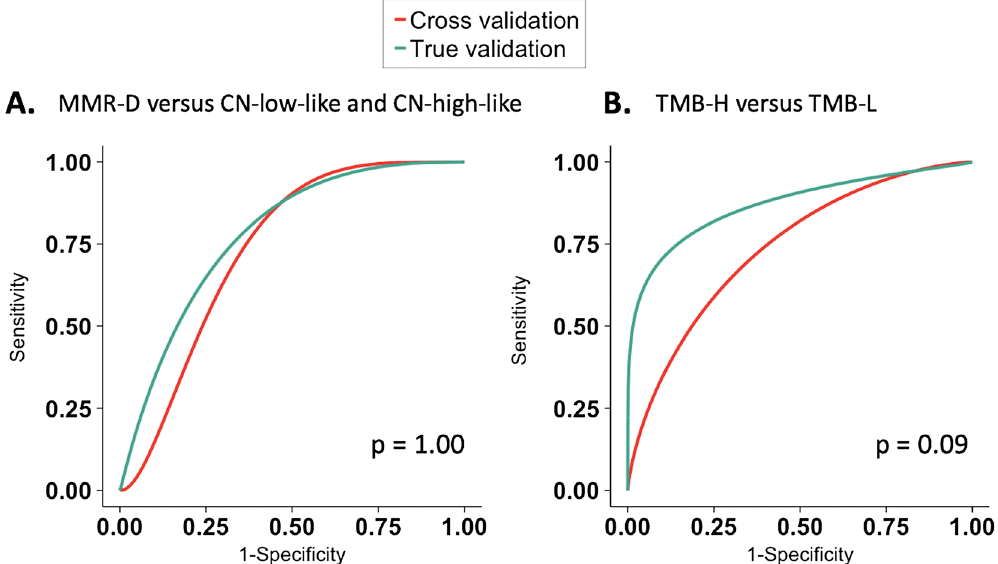
Figure 3. Receiver operator characteristic curves demonstrate the performance of the integrated clinical- radiomic models in the training dataset and the holdout test dataset to ( A ) differentiate MMR-D from CN-low- like and CN-high-like tumors, and ( B ) distinguish TMB-H from TMB-L ECs. EC endometrial cancer, MMR-D DNA mismatch repair-deficient, CN copy number, TMB tumor mutational burden.